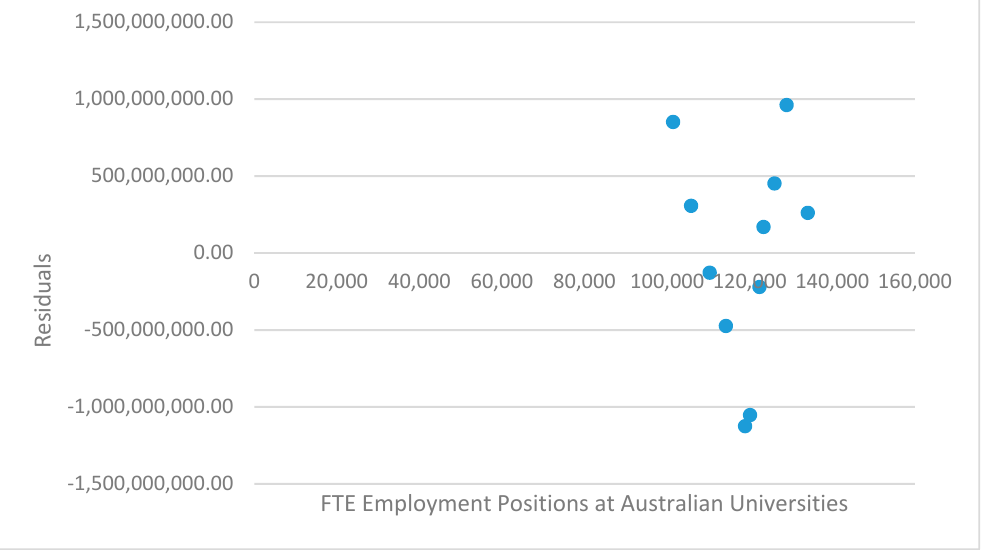
Figure 3. Residual Plot for Full-Time Equivalent (FTE) Employment and Total Australian University Revenue.